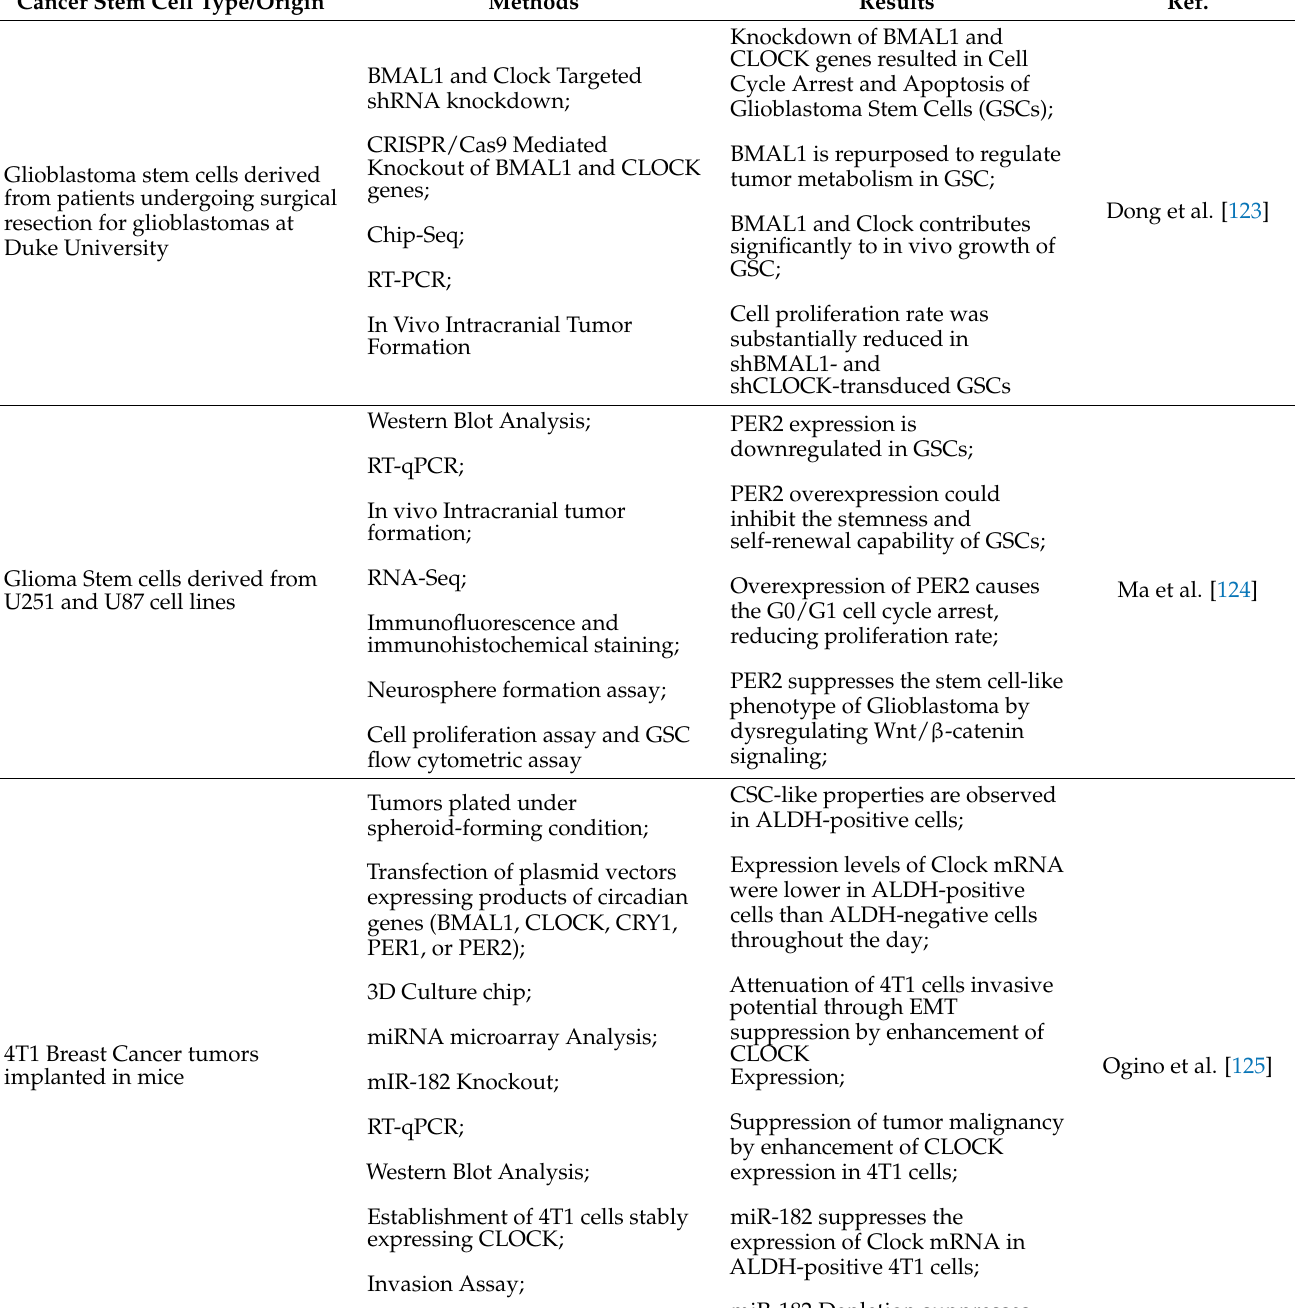
Table 1. The role of circadian clock genes in cancer stem cell